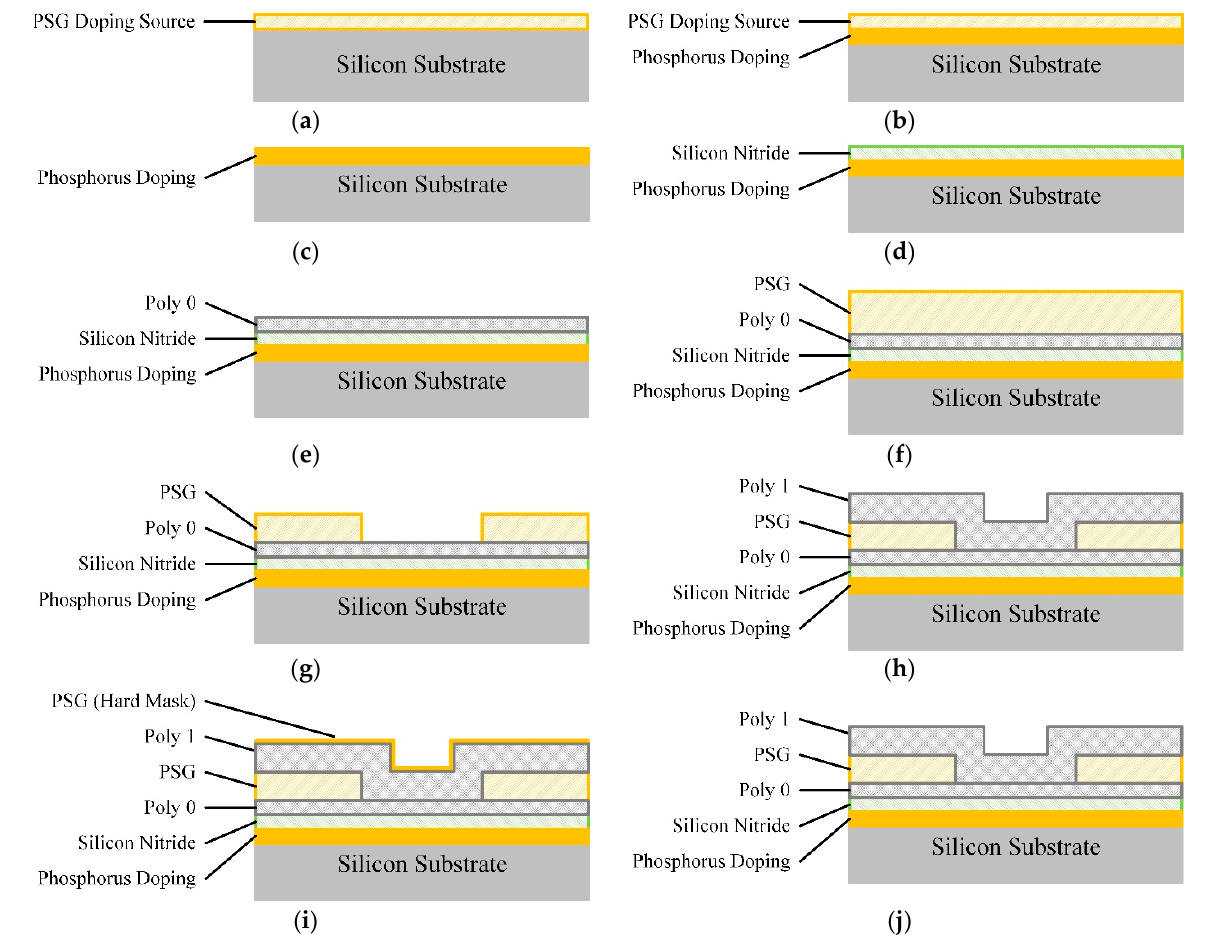
Figure 1. Fabrication process of specimen: ( a ) LPCVD PSG as doping source; ( b ) Doping via annealing; ( c ) Removing of PSG; ( d ) LPCVD SiN as isolation layer; ( e ) LPCVD polysilicon as underlying layer (Poly 0); ( f ) LPCVD PSG as sacrifice layer; ( g ) Etching of sacrifice layer; ( h ) LPCVD polysilicon as structure layer (Poly 1); ( i ) LPCVD PSG as doping source and hard mask of polysilicon; ( j ) Etching of polysilicon and removing of hard mask.